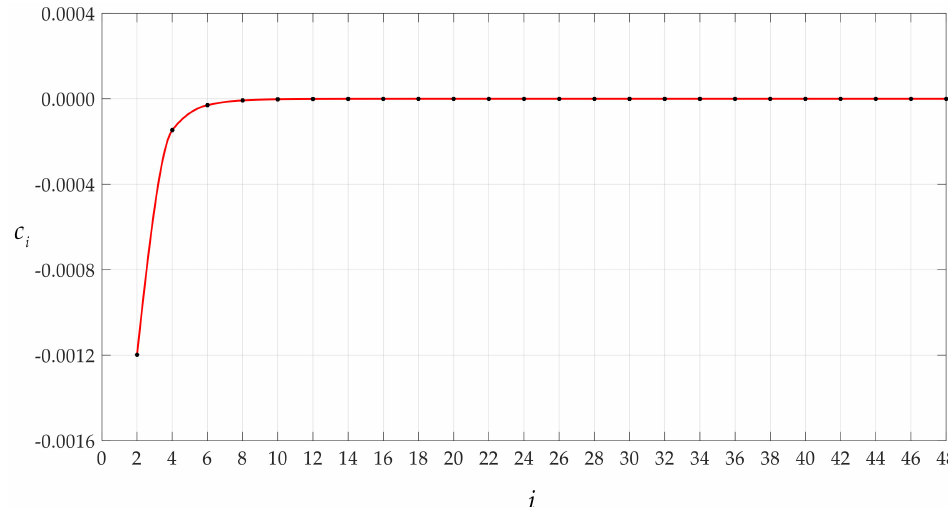
Figure 9. Variations of c i with i when q takes 0.00004